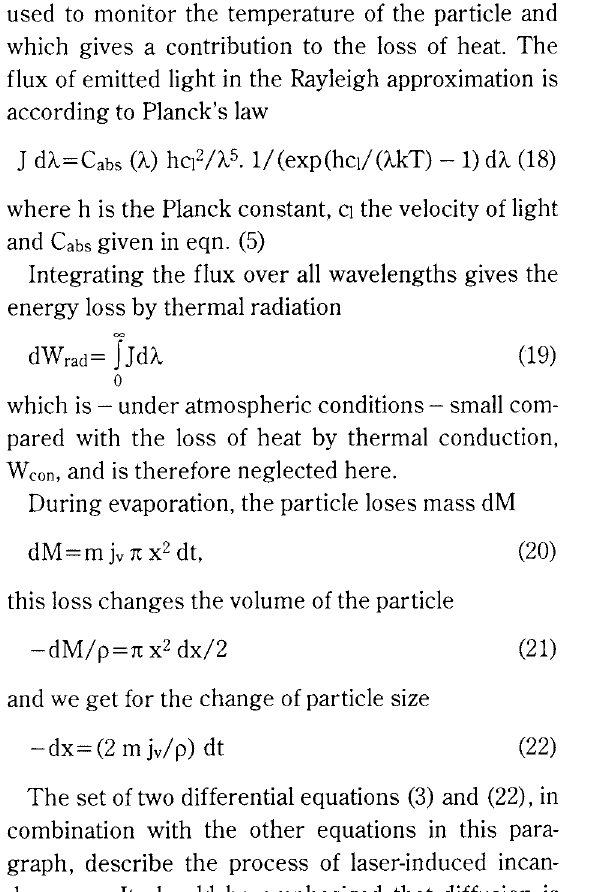
Laser intensity I, vapor pressure Pv, particle size x and particle temperature Tin normalized form as a function of time t. Initial particle size x(t=O) =30 nm, laser fluence W=3000 J m- 2 Laser intensity is normalized to 1 10 12 Wm-2, vapor pressure to 2-10 6 Nm- 2, temperature to 5000